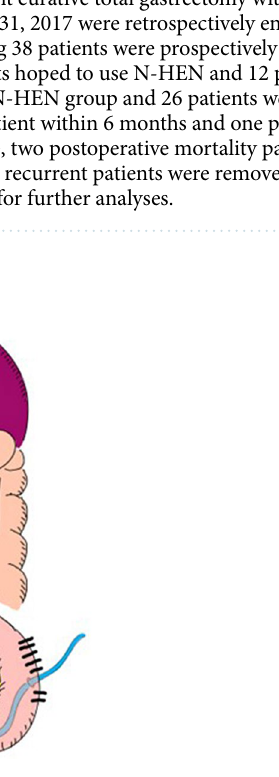
Figure 2. Surgical schema of jejunostomy feeding tube. A jejunostomy feeding tube (9 Fr, 70 cm, Covidien Japan Co., Ltd., Tokyo, Japan) was placed by the Stamm and Witzel procedure at the afferent loop of the jejunum to avoid any tube-related complications. The jejunostomy feeding tube and surrounding jejunum were fixed at the left intra-abdominal wall by an open or laparoscopic/robotic procedure using 3-0 PDS II (Ethicon Japan Co., Ltd., Tokyo, Japan) or 3-0 V-Loc 180 (Covidien Japan Co., Ltd., Tokyo, Japan). Outer fixation was performed at the skin using 3–0